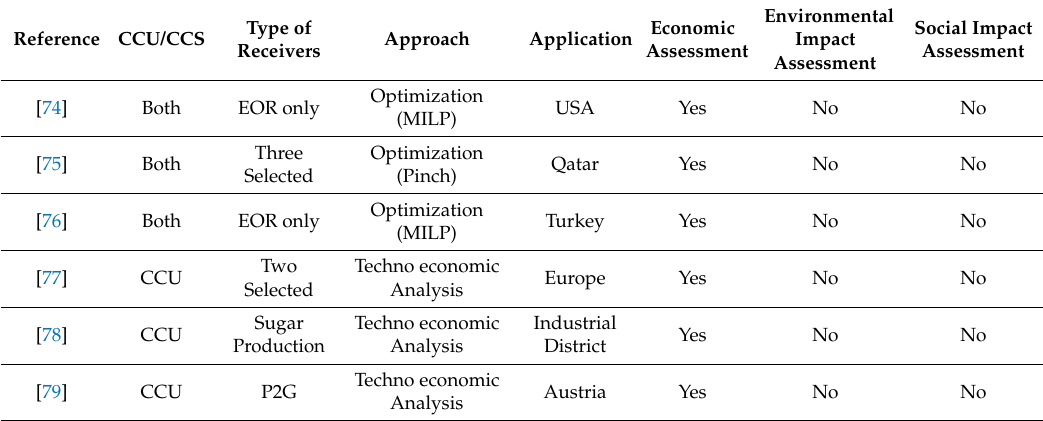
Table 4. Main characteristics of the published CCU modeling